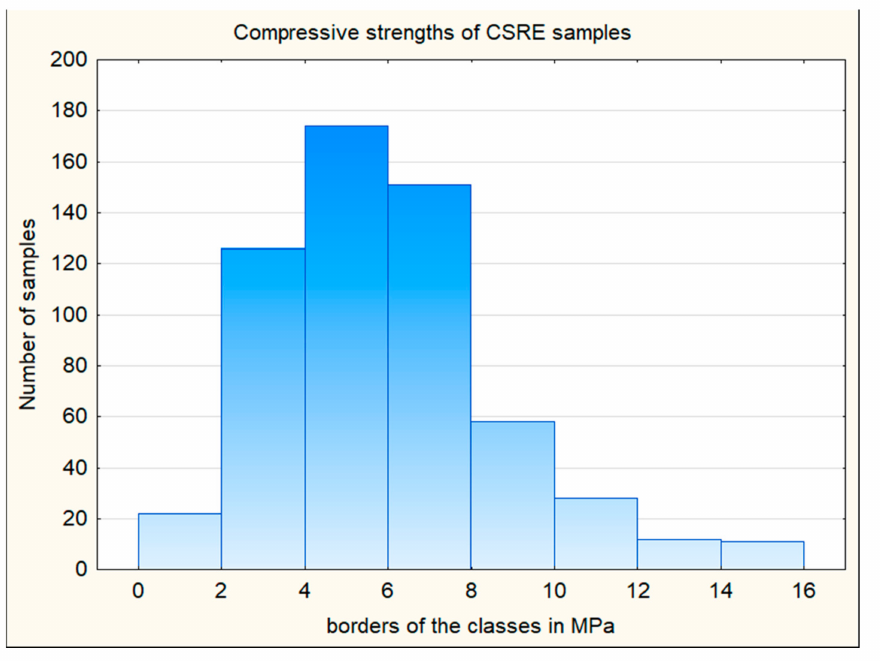
Figure 3. Cement-stabilized rammed earth (CSRE) compressive strength